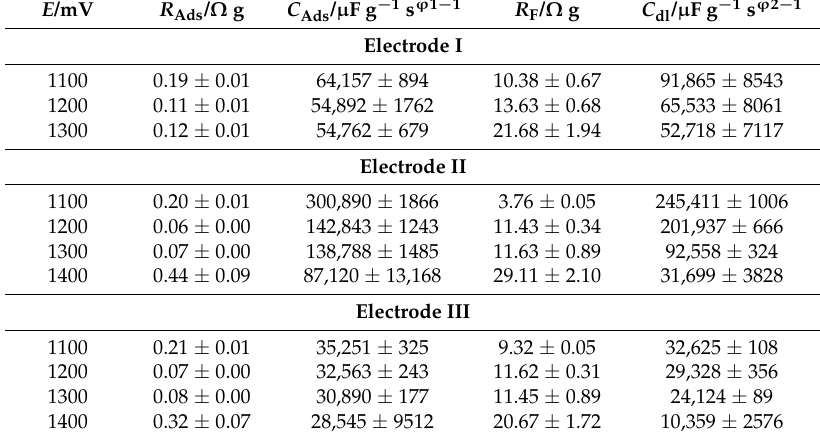
Table 2. Resistance and capacitance parameters for the processes of resorcinol electrosorption and electrooxidation (at 1 × 10 − 3 M) on Ni foam ( I ) and Pd-modified Ni foam ( II ) electrode surfaces in contact with 0.1 M NaOH solution, and Pd-modified Ni foam electrode ( III ) surface in contact with 0.5 M Na 2 SO 4 solution, obtained by fitting the equivalent circuit shown in Figure 7 to the experimentally obtained impedance data (dimensionless ϕ 1 and ϕ 2 parameters, which determine the constant phase angle in the complex-plane plot (0 ≤ ϕ ≤ 1) of the CPE circuit, varied between 0.35 and 0.87). E /mV R Ads / Ω g